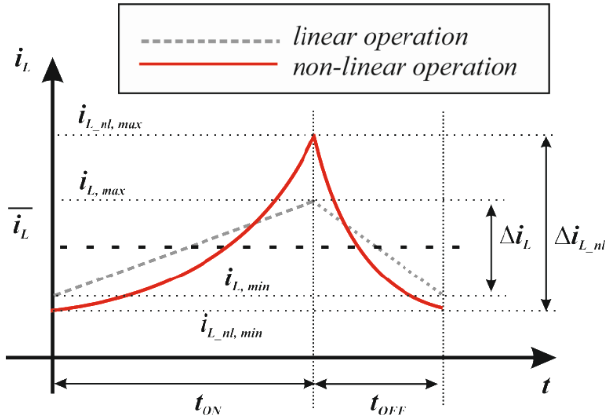
Figure 2. Comparison of current waveforms with linear and non-linear inductors. When the inductance varies with the current, the relationship between inductor voltage v L and flux Φ must be considered.